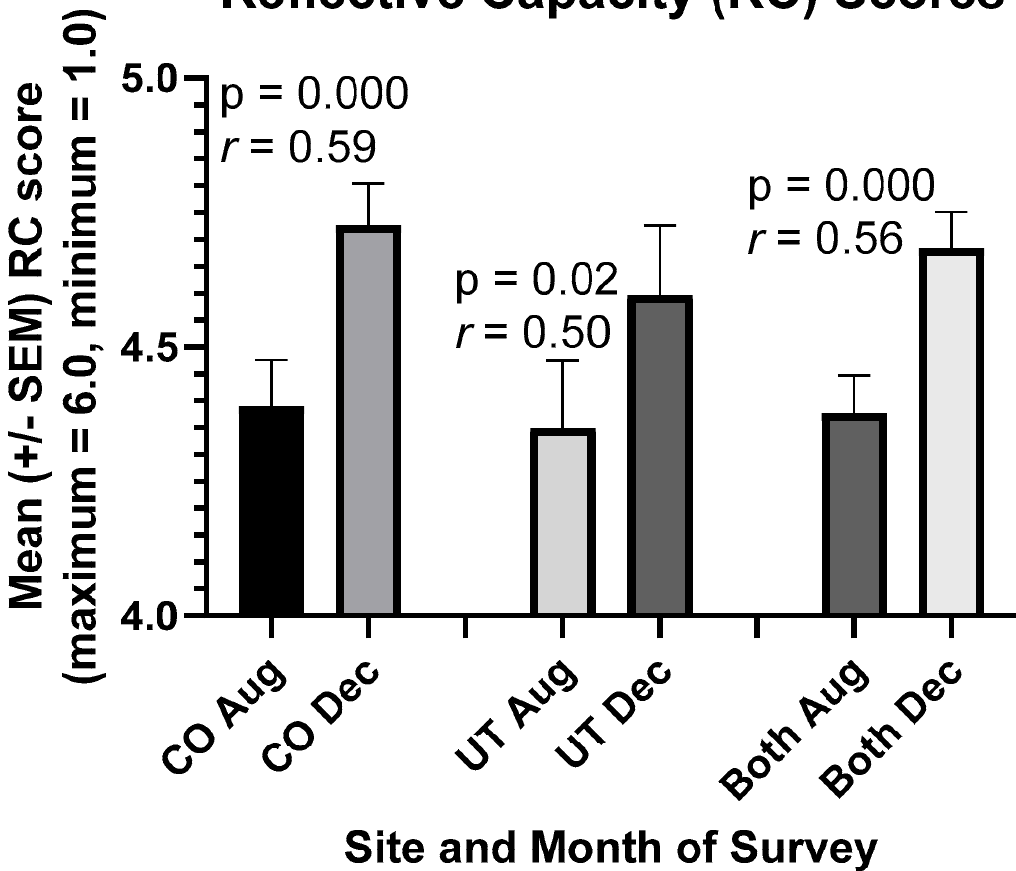
Figure 1. Students’ reflective capacity (RC) scores rose during their Medical Humanities course in 2020. Paired t -tests were used to compare means in Aug and Dec. n = 41 students in Colorado, 20 students in Utah, and 61 students combined (i.e., both).